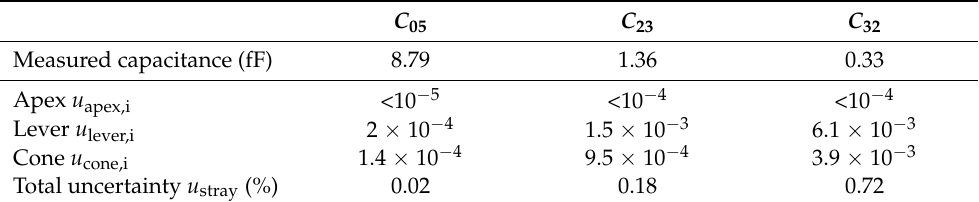
Table A2. Uncertainty components in relative value due to stray capacitances for capacitance values measured on A61F08 pattern reported in Table